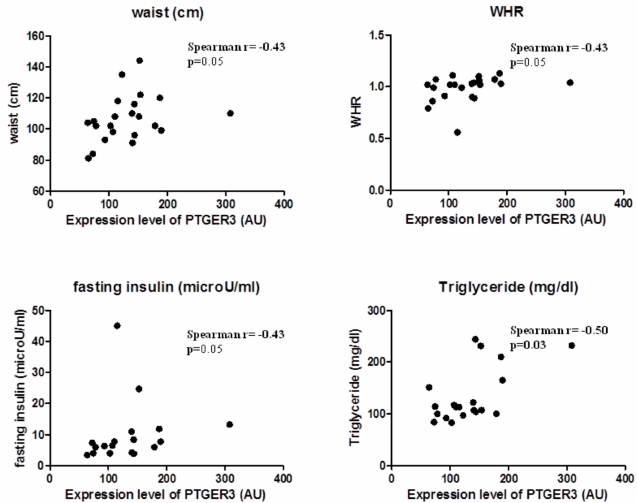
Figure 2. EP3 molecular expression in EAT is associated with body